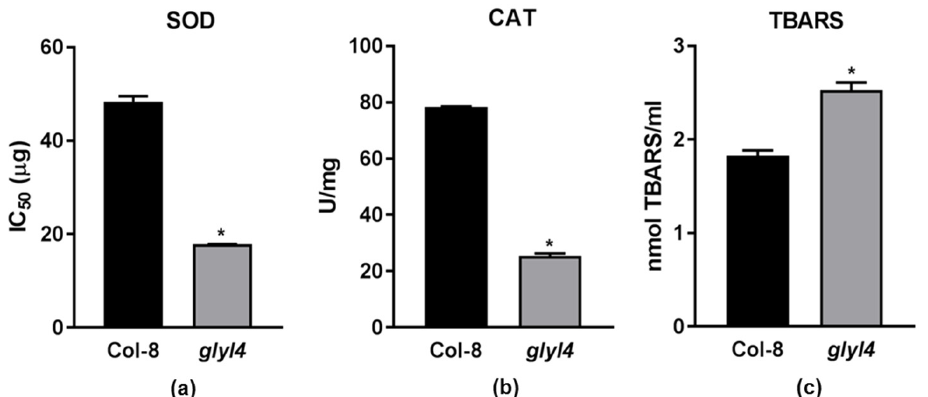
Figure 4. Antioxidant enzyme activities and lipid peroxidation in the glyI4 mutant. ( a ) superoxide dismutase (SOD); ( b ) catalase (CAT); ( c ) TBARS. Asterisks indicate statistically significant difference between genotypes. (Mann–Whitney test p -value < 0.05). Error bars represent means ± SDs ( n = 3).